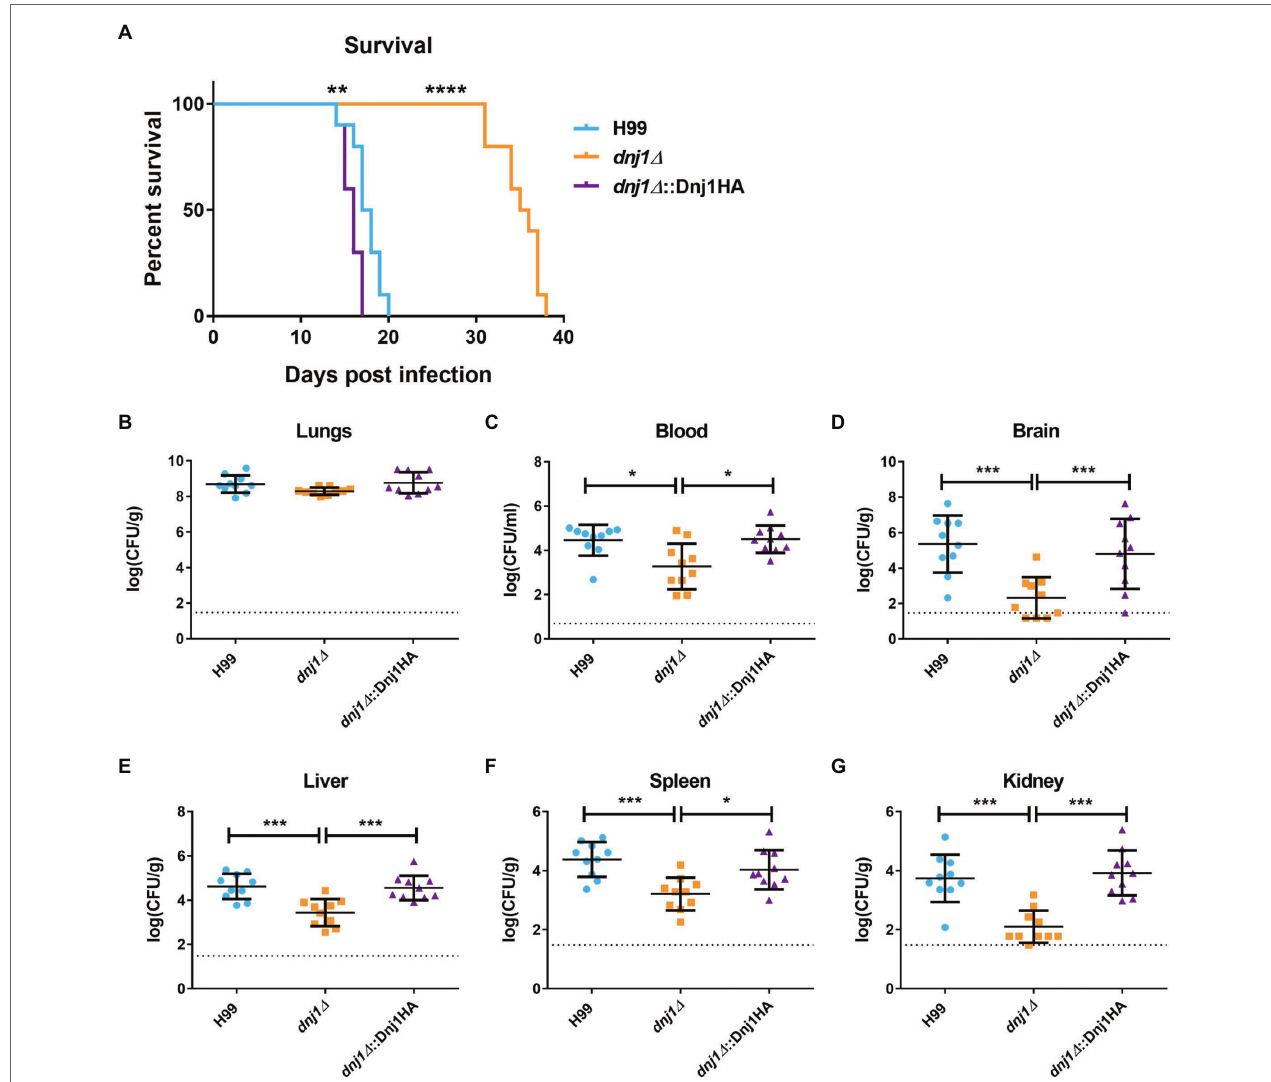
FIGURE 8 | Dnj1 contributes to virulence and dissemination of C. neoformans in a mouse model of cryptococcosis. (A) Mice infected with the wild type (H99) and complemented strains ( dnj1 Δ ::Dnj1HA) succumbed to infection between 14 and 20 days, whereas mice infected with the dnj1 Δ deletion mutant survived to between 31 and 38 days post infection. Survival differences were determined using a log-rank test (** p < 0.01 and **** p < 0.001). (B–G) The fungal loads for mice infected with each strain were determined by measuring colony-forming units (CFUs) retrieved from the indicated homogenized tissues. Each dot represents the CFUs recovered from one mouse and the mean and SD are indicated for each group. The dashed line indicates the limit of detection for each organ based on the dilutions used in the experiment. Statistical significance of the differences observed were evaluated by Mann-Whitney U tests (* p < 0.05 and *** p < 0.005). Dashed horizontal lines indicate the limit of detection for the